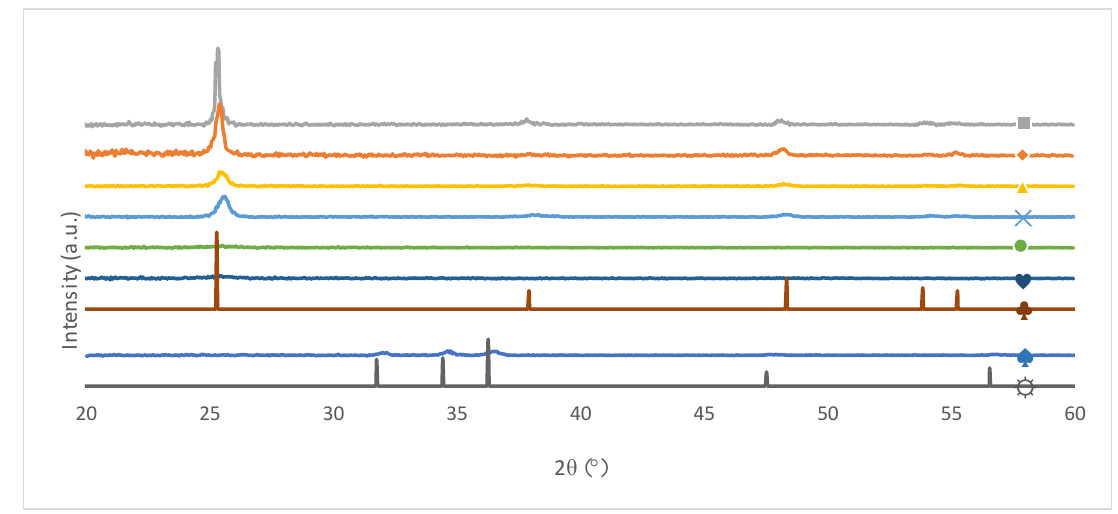
Figure 1. Grazing incidence diffractograms of all samples. ■ TiO 2 org; ◆ TiO 2 + Ag; ▲ TiO 2 + P25; ✕ TiO 2 + MnO 2 ; ● TiO 2 aq; ♥ TiO 2 + Zn 2+ ; ♣ Anatase (from database RRUFF R060277); ♠ ZnO; ☼ Zincite (from database RRUFF R050492).